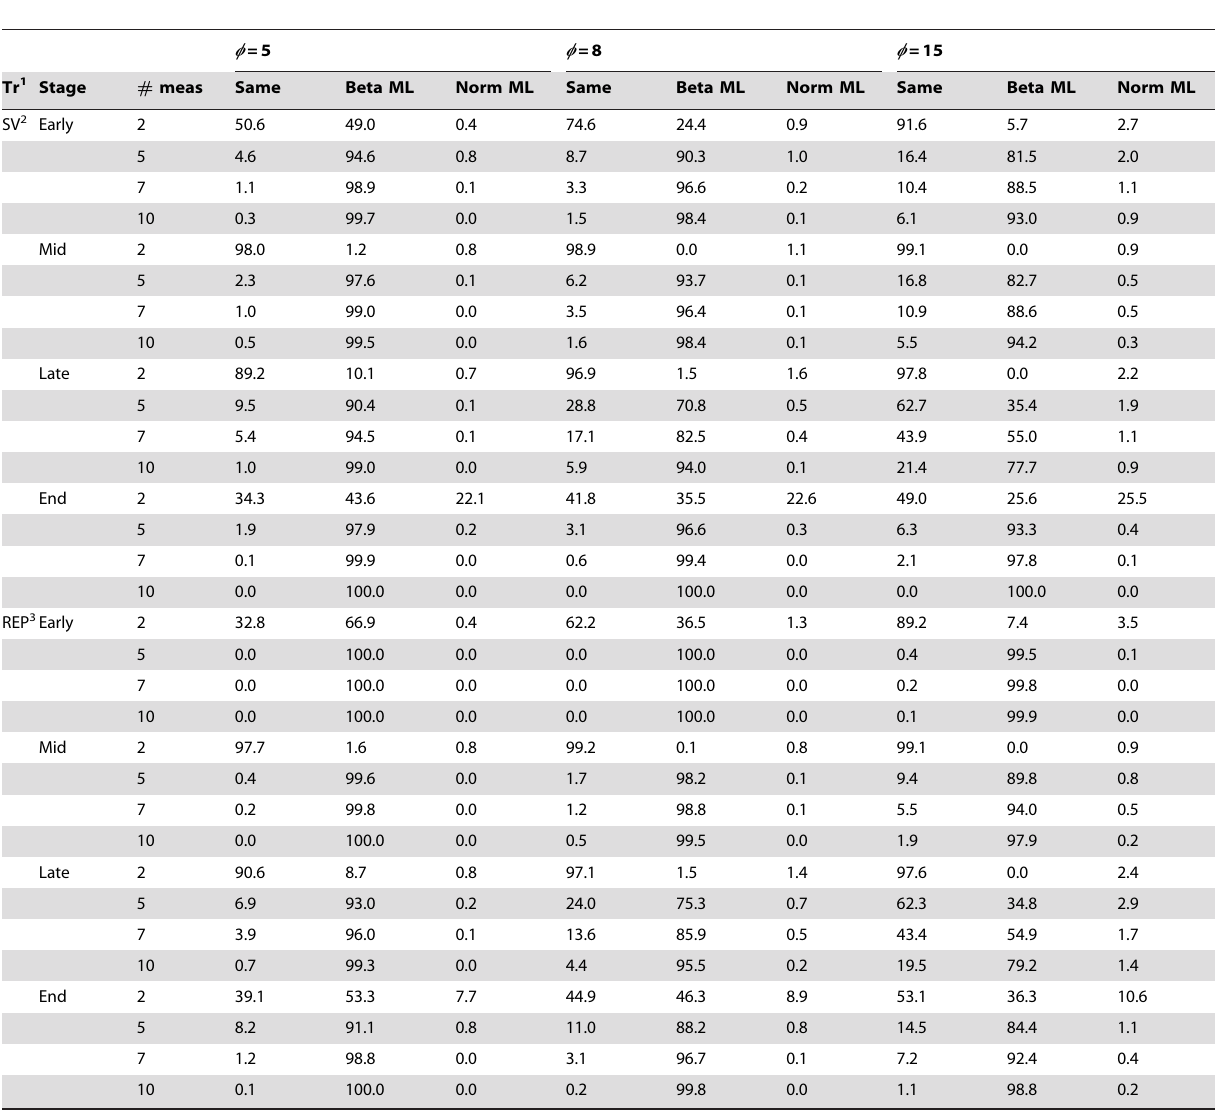
Table 4. Percent of beta error simulations with normal error ( s =0.0125) added, for which AIC c selected maximum likelihood (ML) estimation with beta or normal errors best or found no difference between the models (Same) from each simulation ( k = 0.0002).